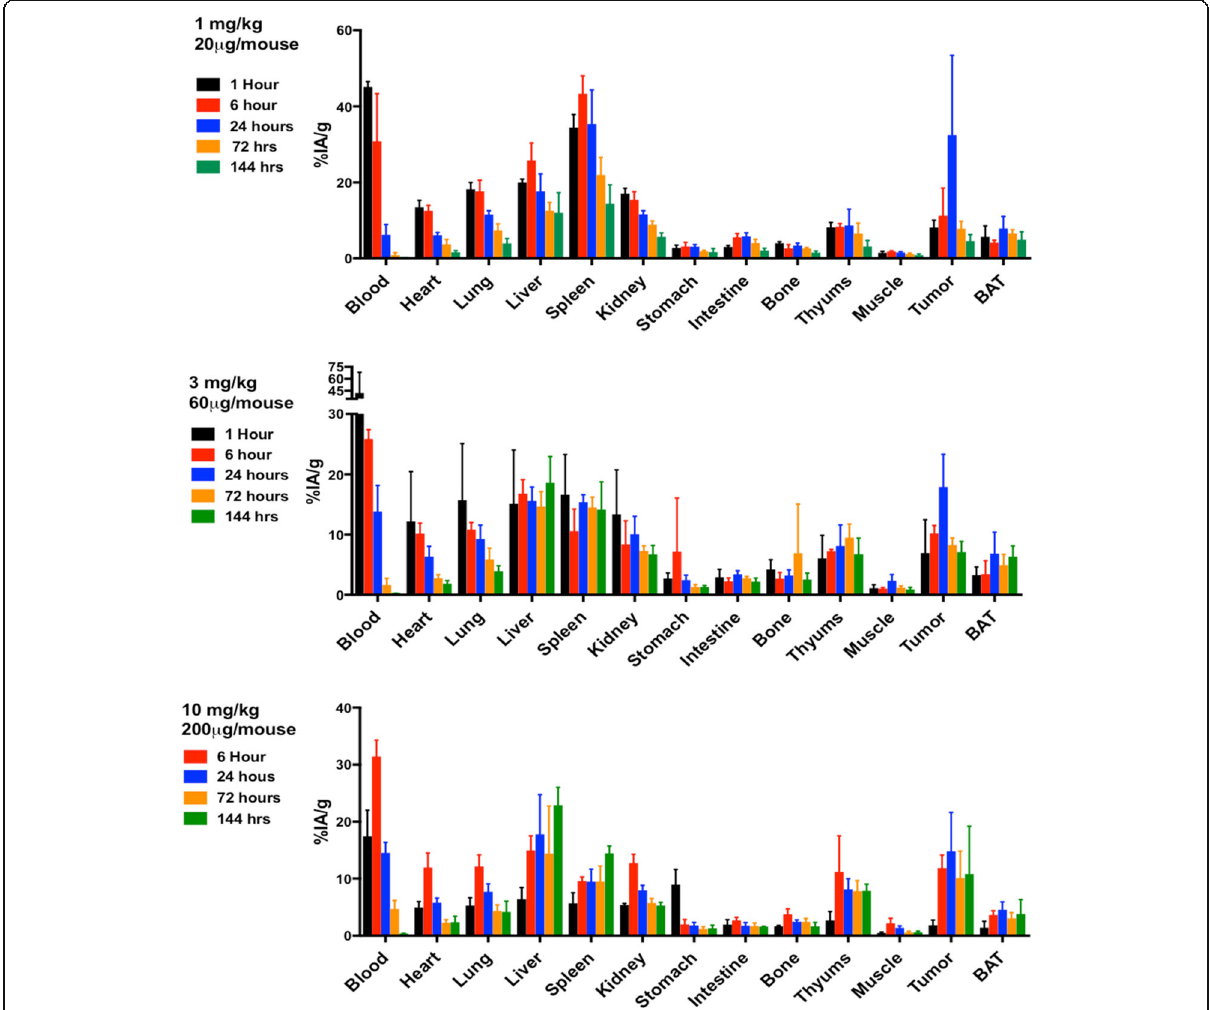
Fig. 4 Biodistribution of 111 In-DTPA-anti-PD-L1-BC (370 kBq) at 1, 6, 24, 72, and 144 h in neu -N mice bearing NT2.5 tumors. 111 In-DTPA-anti-PD-L1-BC was administered at the following doses: 1 mg/kg (20 μ g/mouse), 3 mg/kg dose (60 μ g/mouse), and 10 mg/kg (200 μ g/mouse)